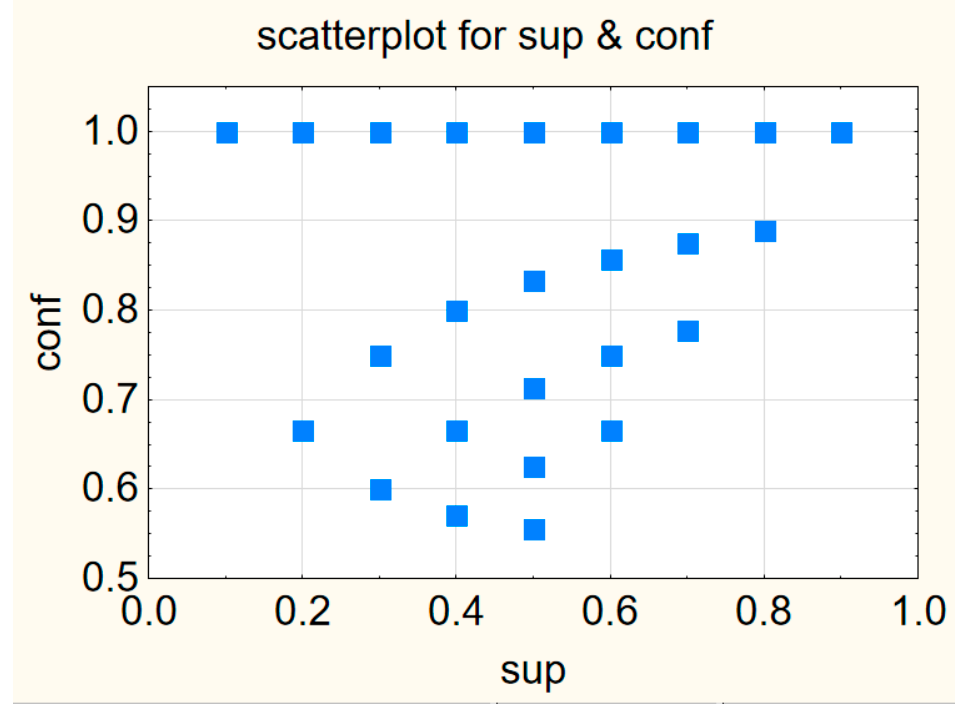
Figure 7. Two-dimensional scatterplot of sup and conf for all rules presented in Appendix A Table A1. The database assumed to create the 7-Score is 10 × 10, considering